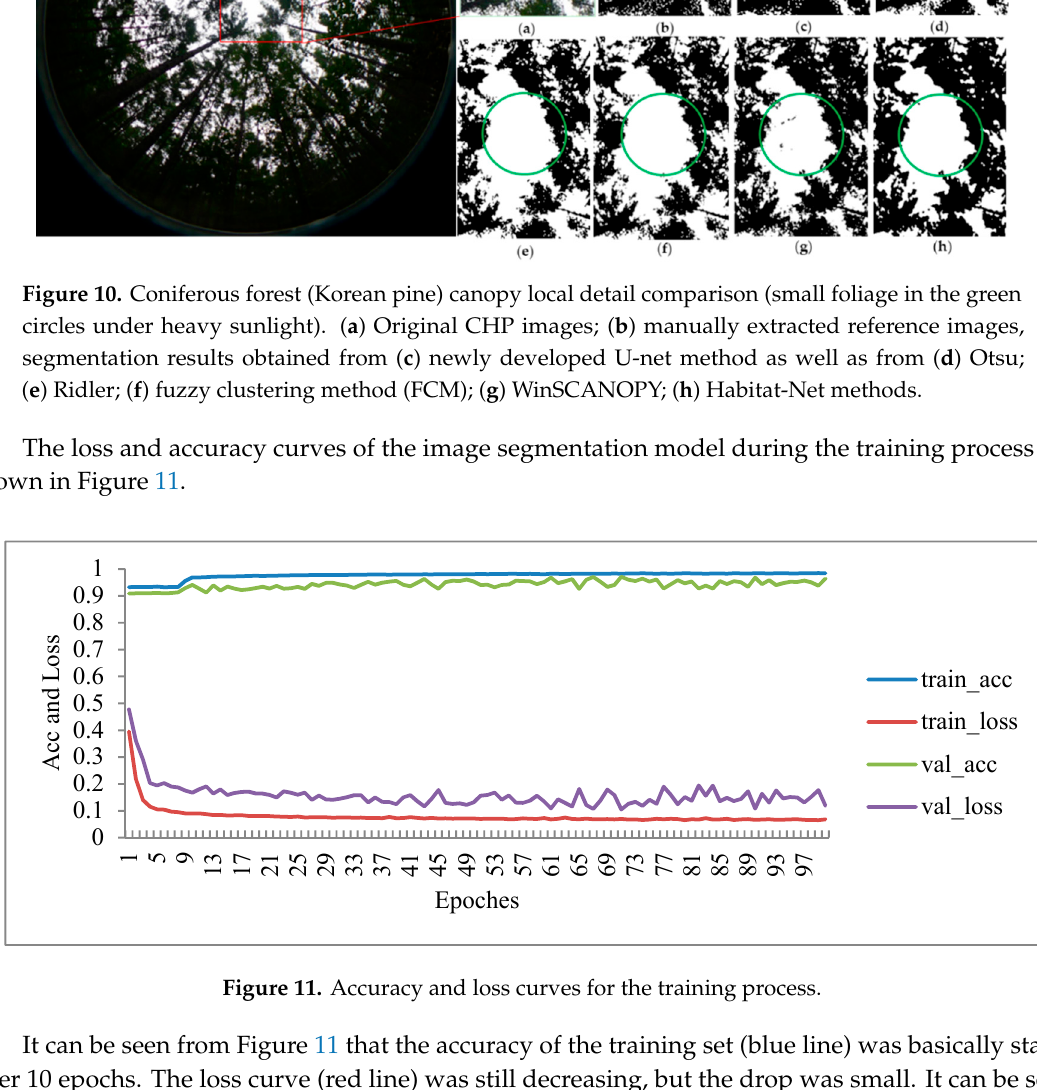
Table 1. Results for the six segmentation methods. DSC: Dice similarity coefficient.